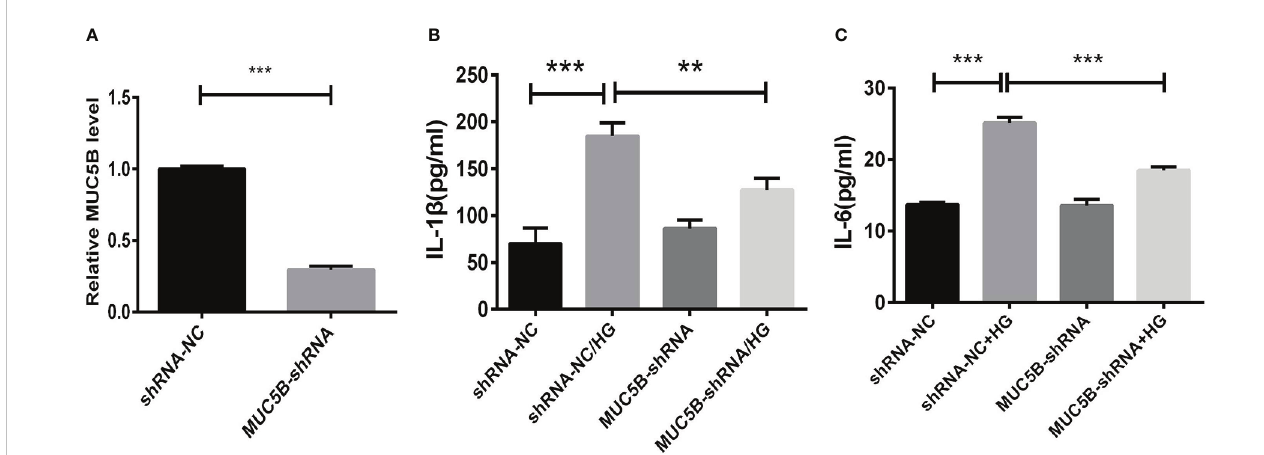
FIGURE 6 Effects of MUC5B on cytokine production in BEAS-2B cells stimulated by high glucose. (A) The ef fi ciency of MUC5B -ShRNA transfection into BEAS-2B cells was detected by RT-PCR. After MUC5B knockdown, BEAS-2B cells were stimulated by 30mM glucose for 72 hours. (B) IL-1 b and (C) IL-6 in the supernatant were both signi fi cantly increased compared to the control (** P < 0.01, *** P <